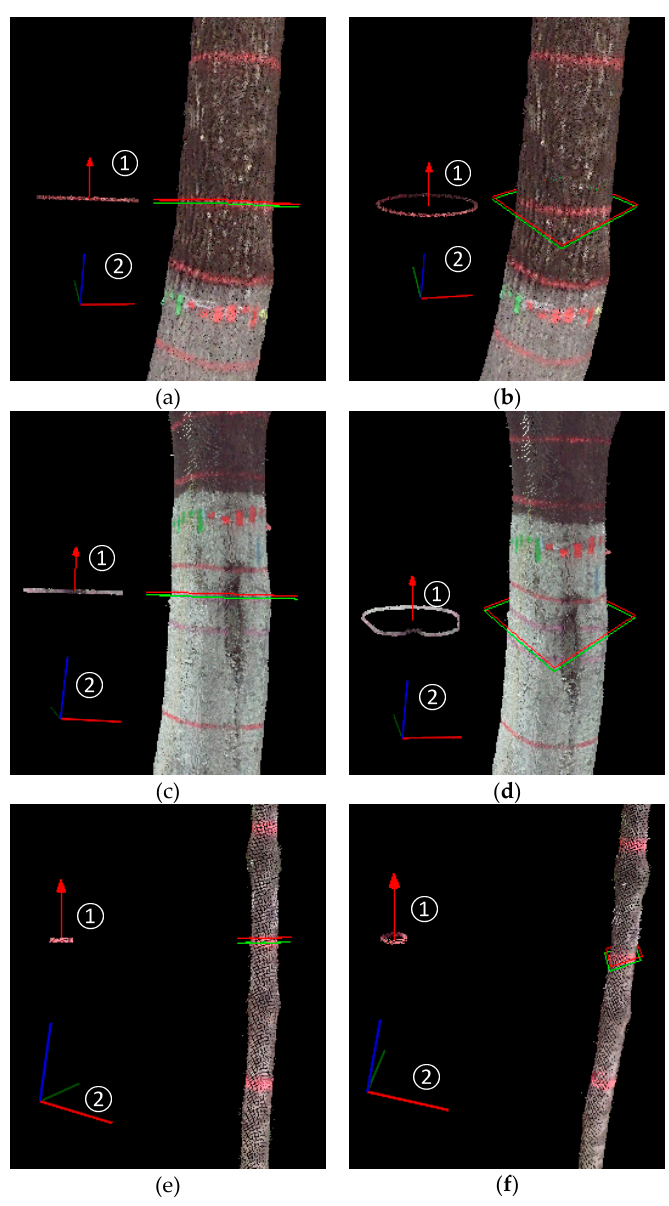
Figure 4. Stem cross-sectional planes of trees. ( a ) Front view of Tree 002; ( b ) side view of Tree 002; ( c ) front view of Tree 003; ( d ) side view of Tree 003; ( e ) front view of Tree 007; ( f ) side view of Tree 007. ① represents a copy of the stem cross-sectional points, and ② represents the coordinate axis. The red arrow represents the normal vector of the stem cross-sectional plane. The red rectangle represents the upper stem cross-sectional plane. The green rectangle represents the lower stem cross-sectional plane. The length of the coordinate axis is 20 cm.